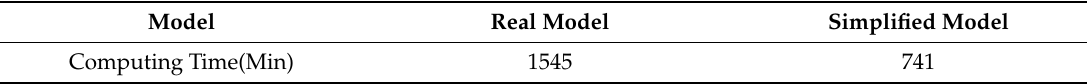
Table 3. The comparison of simulation time.